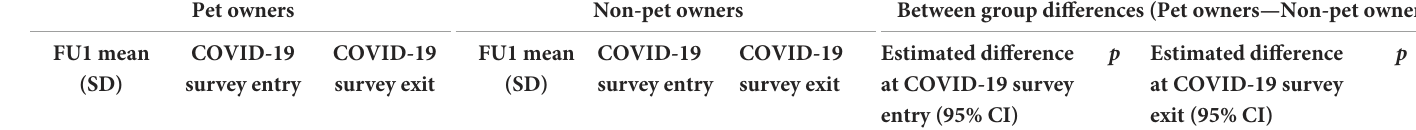
TABLE 8 Estimated marginal means and standard errors for sex differences in changes in 10-item Center for Epidemiological Studies Depression Scale (CESD-10) score at FU1 (i.e., 2015–2018), and COVID-19 Survey entry and exit based on mental health disorder status and pet